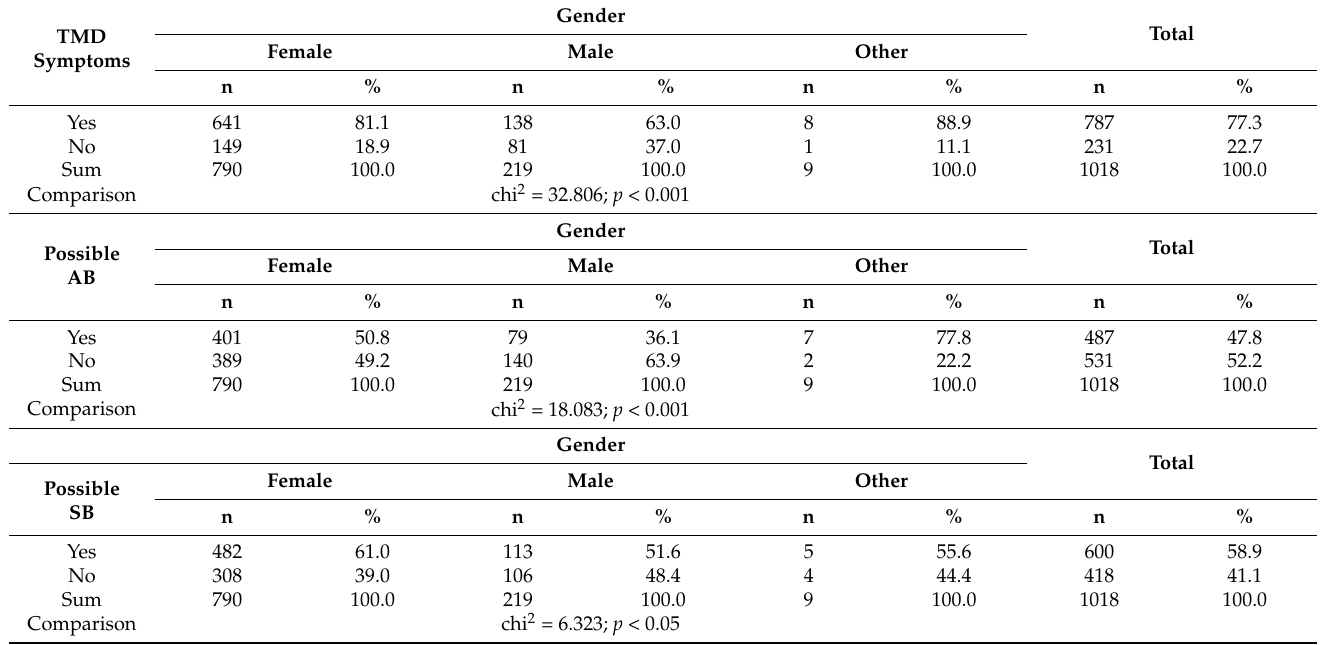
Table 1. Frequency of TMD symptoms and possible AB and SB among genders in the tested population.